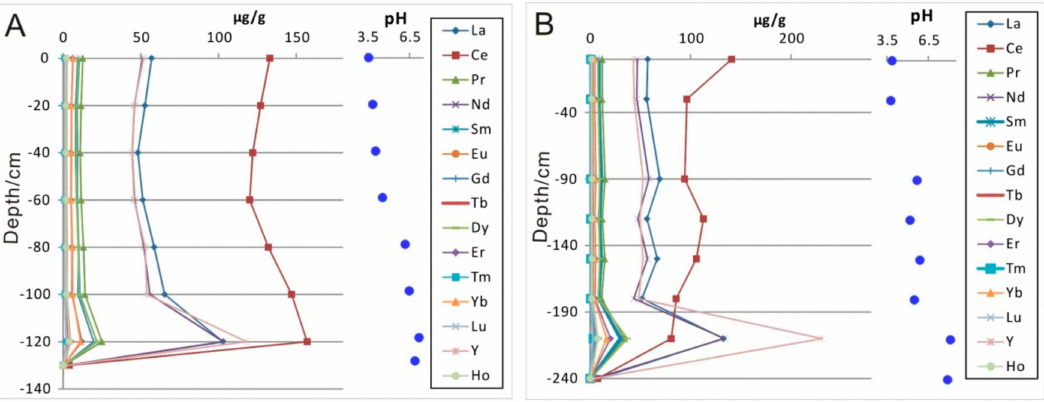
Figure 7. The variation of REEs and pH with depth in ( A ) SC and ( B ) TG